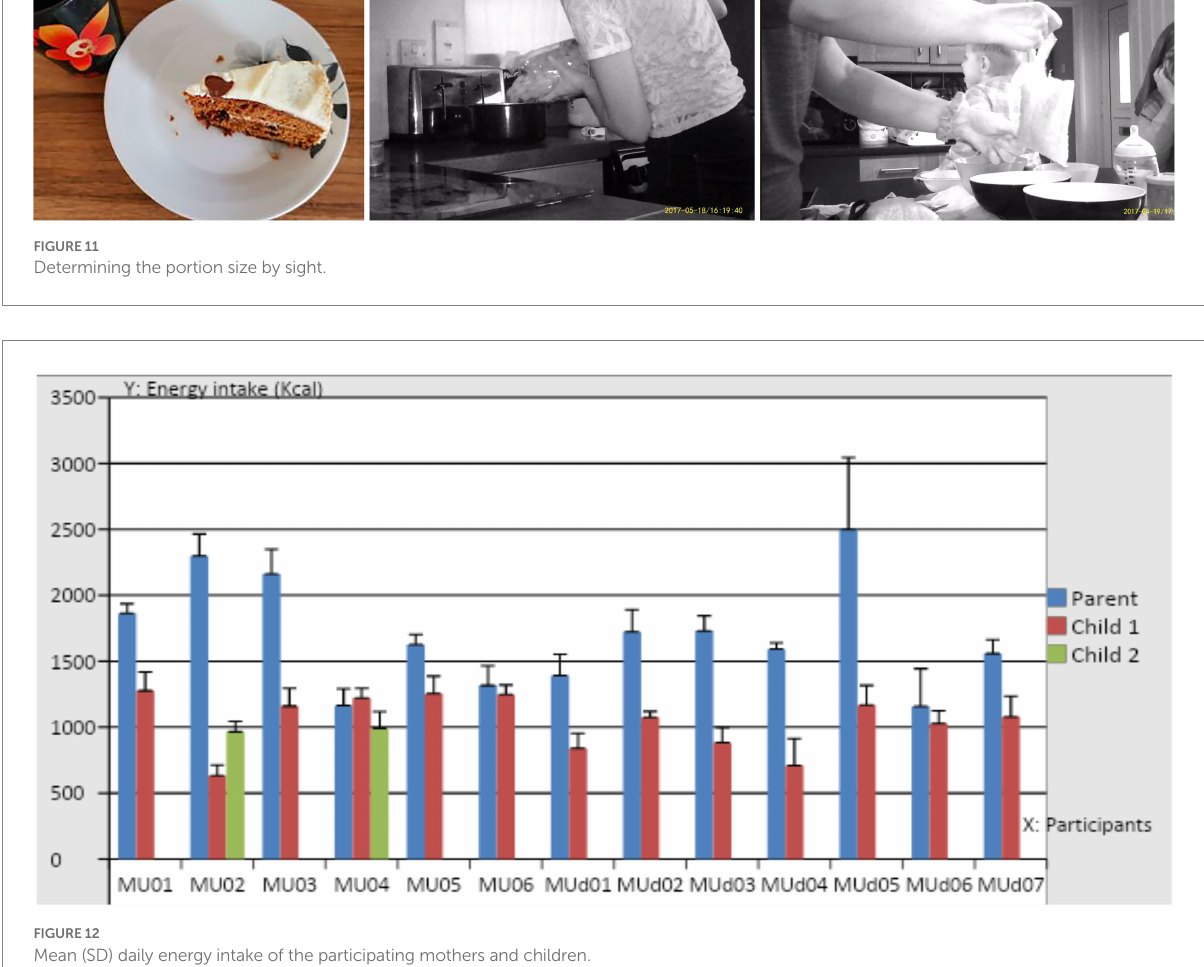
FIGURE 12 Mean (SD) daily energy intake of the participating mothers and children.